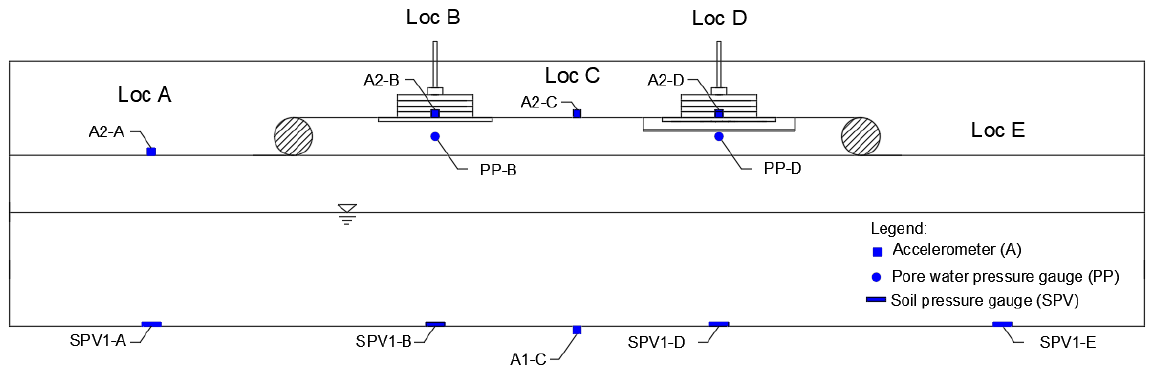
Figure 13. Sensor locations and labels.